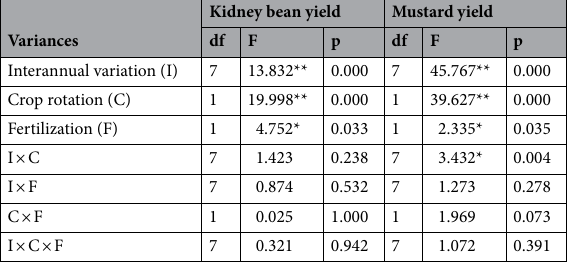
Table 4. ANOVA for kidney bean and mustard under different rotation–fertilization treatments 2013–2020. Stars indicated the level of signifcance (*p < 0.05,**p < 0.01).